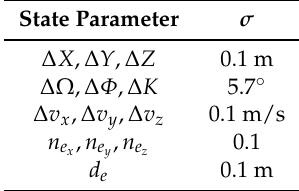
Table 2. Scheduled standard deviations σ for the initial VCM Σ xx ,0 of the initial state vector x 0